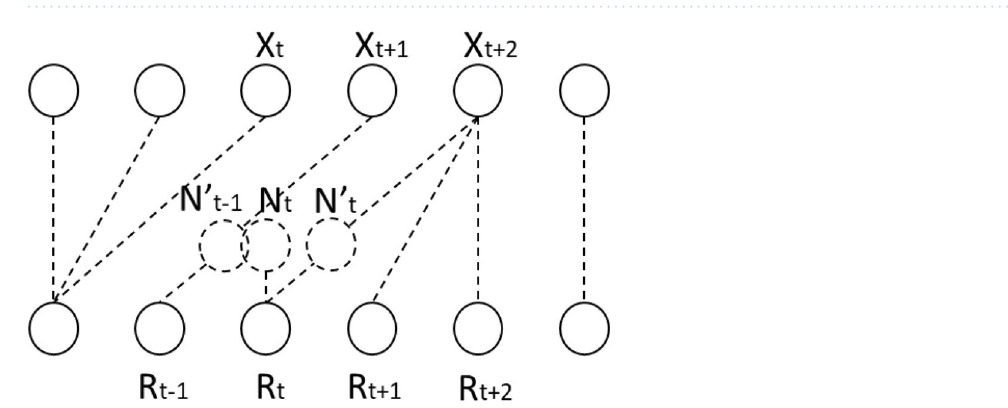
Figure 3. Calculation of new neuron weights N t using DTW alignment. N’ t and N’ t-1 are the weighted means of two adjacent DTW pairs; however, neither match existing timestamps. To calculate N t , we approximate its value using N’ t and N’ t-1